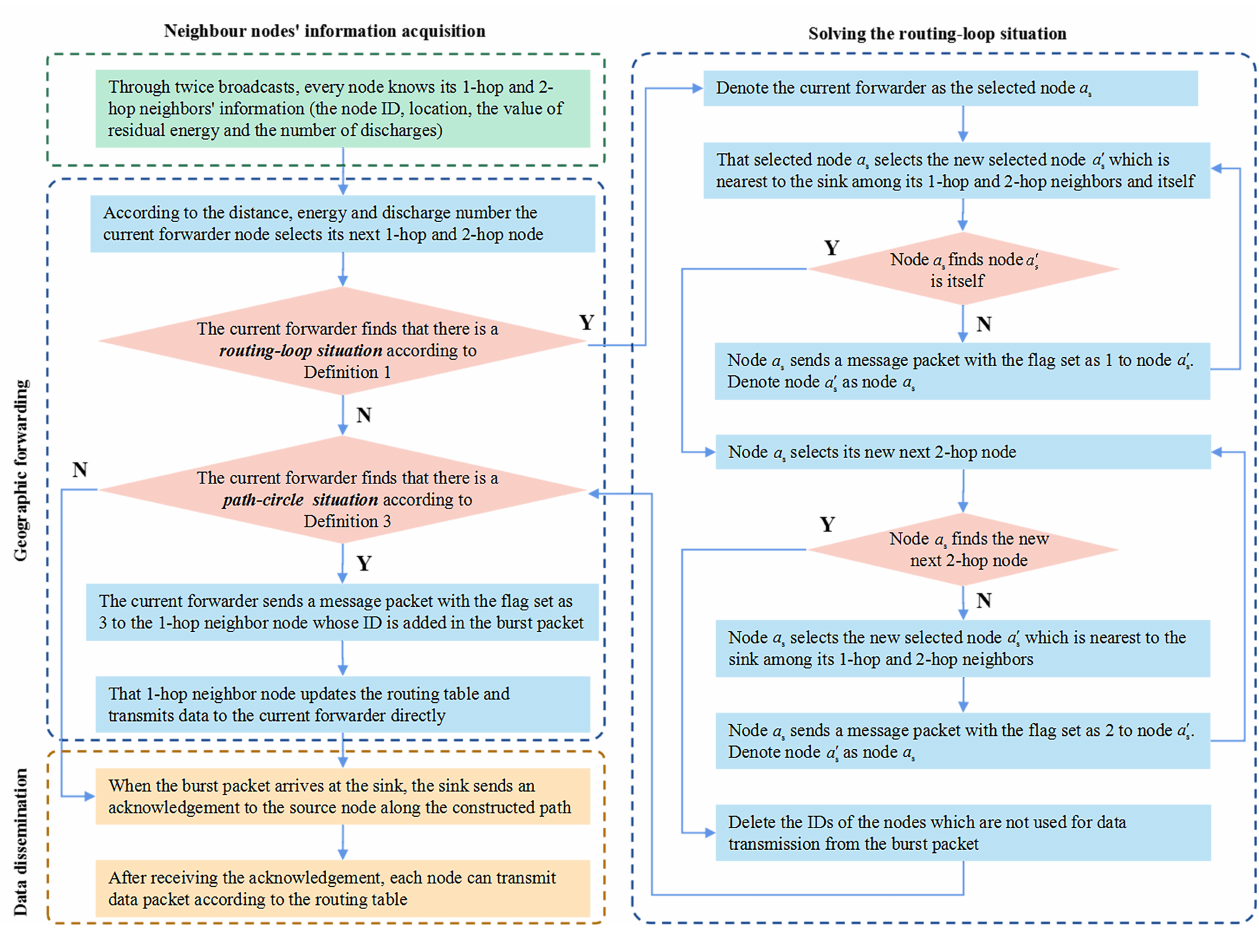
Figure 4. The flow chart of